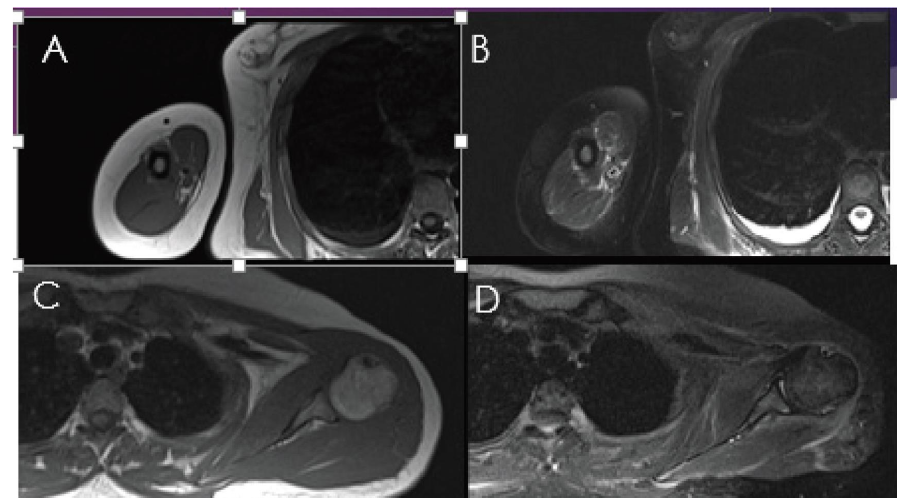
Figure 3: MRI of right arm T1W (a) and fat sat (b) and (c)-(d) MRI of left shoulder T1W (c) and fat sat (d) sequences. Note to the difuse perimuscular and fascial edema more along the latissimus dorsi and rotator cuf muscles (arrows).